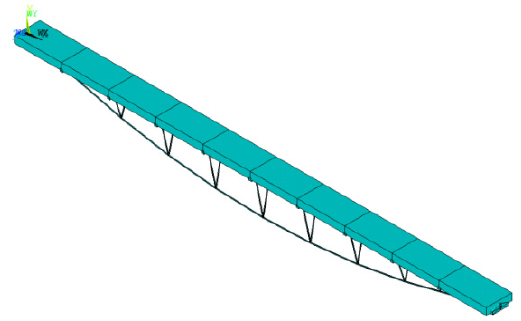
Figure 4. Dynamic finite element model.